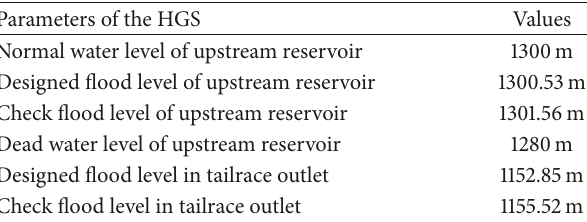
Figure 6: Overall methodology of this work. Table 1: Head level information of an existing HGS.